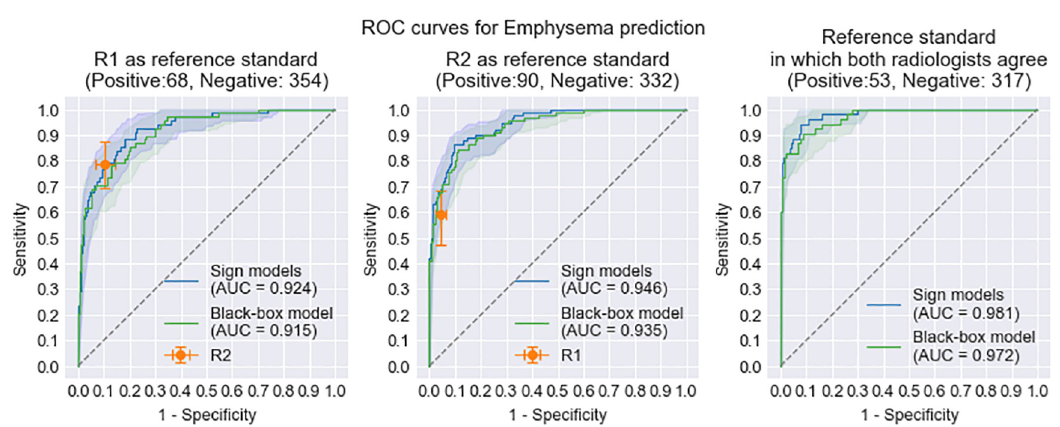
Fig 5. ROC curve comparison of the combined emphysema signs model for detecting emphysema with at least 2 signs, the black-box emphysema model, and a radiologists sensitivity specificity point. ROC curves are drawn for 2 different reference standards. R1 as reference standard (left)and R2 as reference standard (centre), and finally for only those cases where the radiologists agreed on the emphysema label (right). The 95% confidence intervals and error bars are calculated by